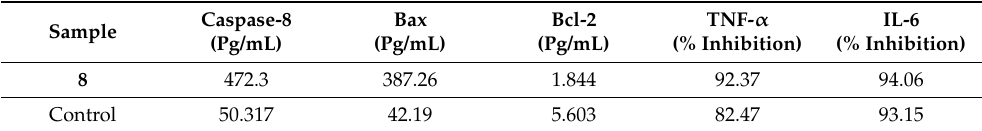
Table 6. Effects of compound 8 (5.4 µ M) on the expression levels of caspase 8, Bax, and Bcl-2; and TNF- α and IL-6 inhibition in the treated HCT-116 cells for 24